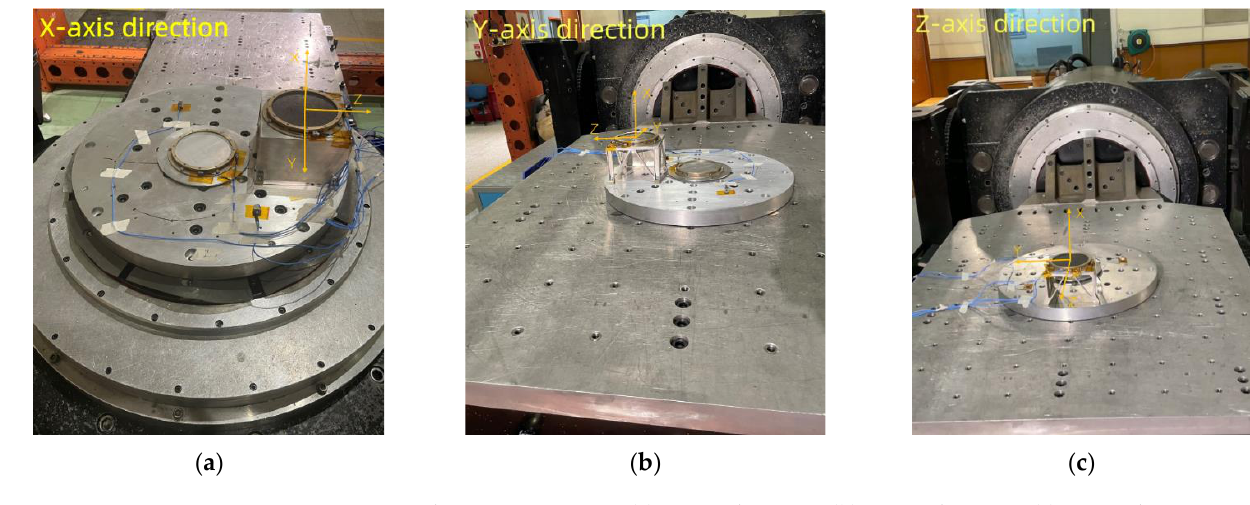
Figure 4. Vibration testing site: ( a ) X-axis direction. ( b ) Y-axis direction. ( c ) Z-axis direction.